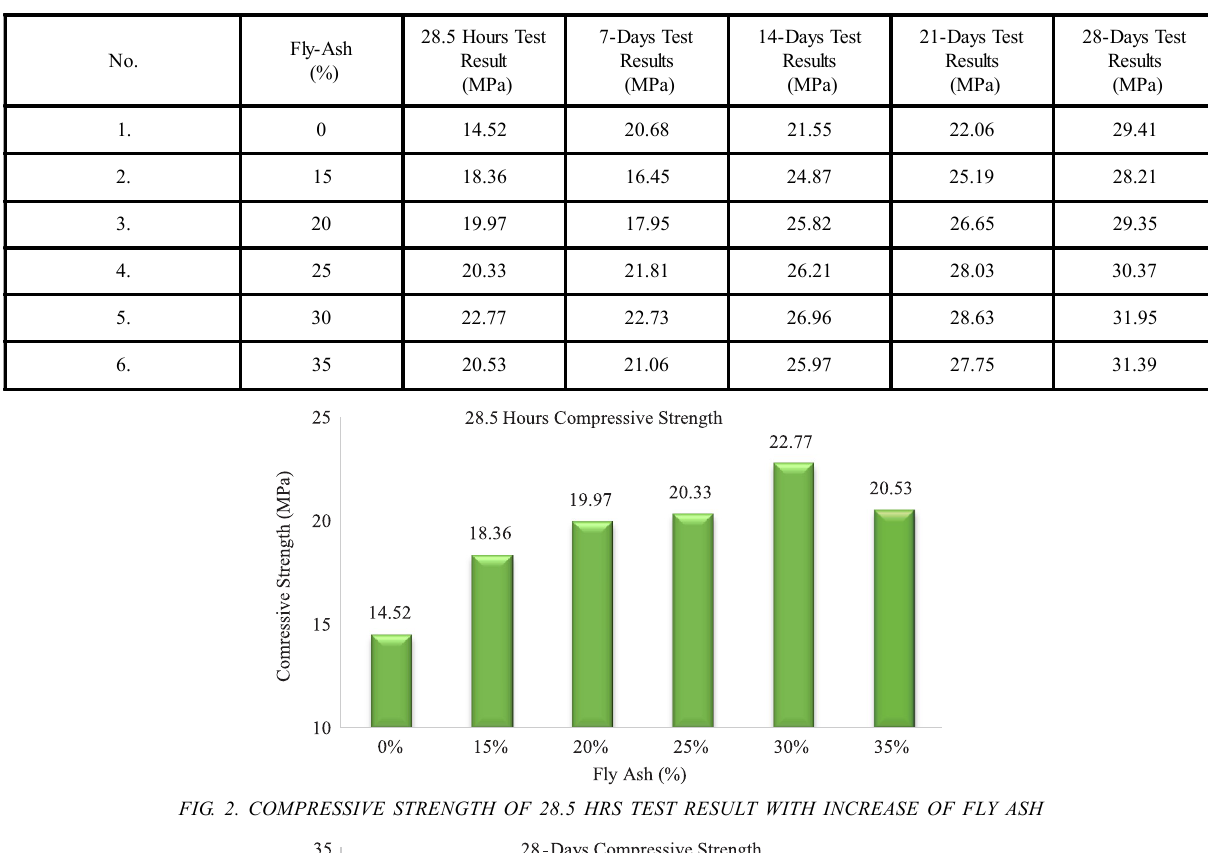
TABLE 2. RESULTS OF COMPRESSIVE STRENGTH TEST